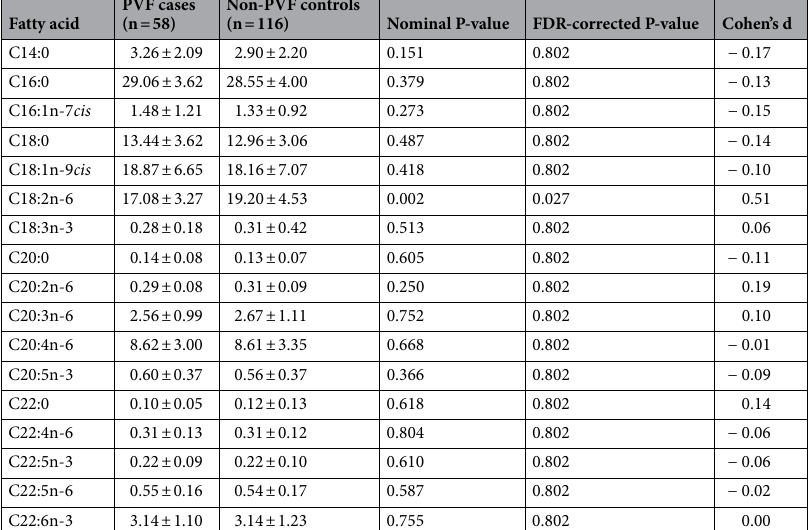
Table 2. Proportion of fatty acids in serum phospholipids in primary ventricular fibrillation (PVF) cases and matched controls at hospital admission for STEMI. Data are presented as mean ± standard deviation. Nominal P-values were assessed by Student’s t test, and the Benjamini–Hochberg procedure was applied on nominal P-values to control the false discovery rate (FDR).